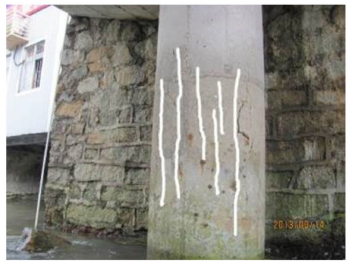
Figure 5. Cracks on The surface of pier #1.